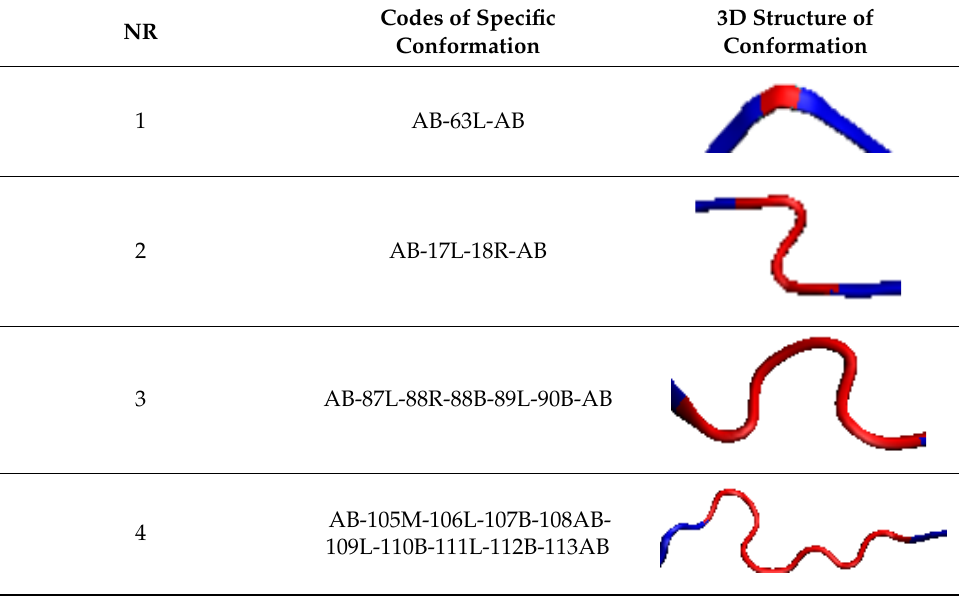
Figure 5. Superposition of pairs of Phi, Psi angles for transthyretin — reference form 1DVQ ( A , B ) and amyloid form — 6SDZ ( C , D ) (red points): ( A , C ) — on radius of curvature map; ( B , D ) — V-angle map. Green line visualizes the position of Psi = − Phi. The approach to this line can be seen in amyloid forms in respect to the distribution observed in WT form of transthyretin. The blue circles visualize the low distribution of angles in right- and left- handed α -helix in amyloid form in respect to analo- gous WT forms of transthyretin. Figure 5 presents the illustration of the proposed classification of conformations in the form of distribution of the Phi and Psi angles plotted on the maps of the radius of curvature R and the V angle. The comparative analysis of the distribution of Phi and Psi angles on the Ramachan- dran map for the native and amyloid forms of transthyretin shows their concentration in the area of the maximum value of the radius of curvature and the V angle close to 180 degrees, as well as the increase in the number of points and their clear focus around